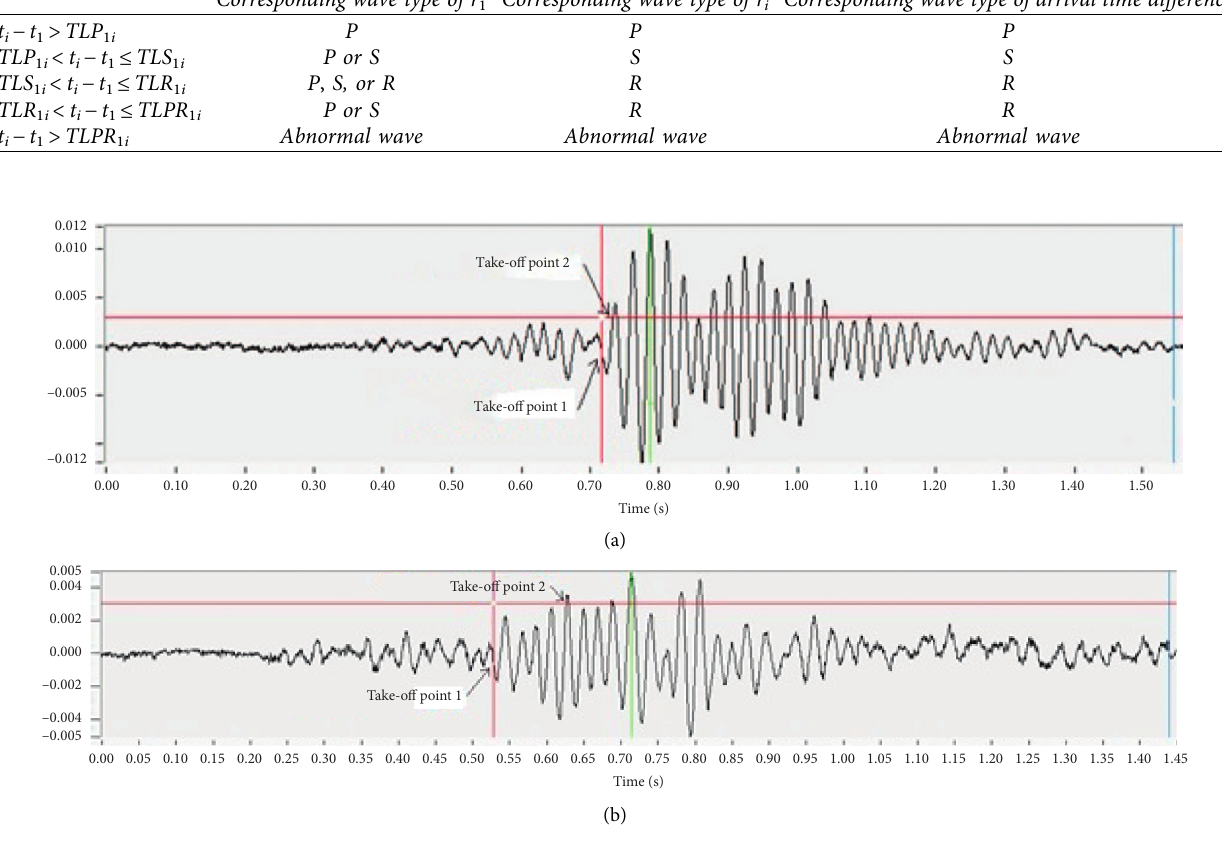
Figure 2: First arrival point based on the use of different